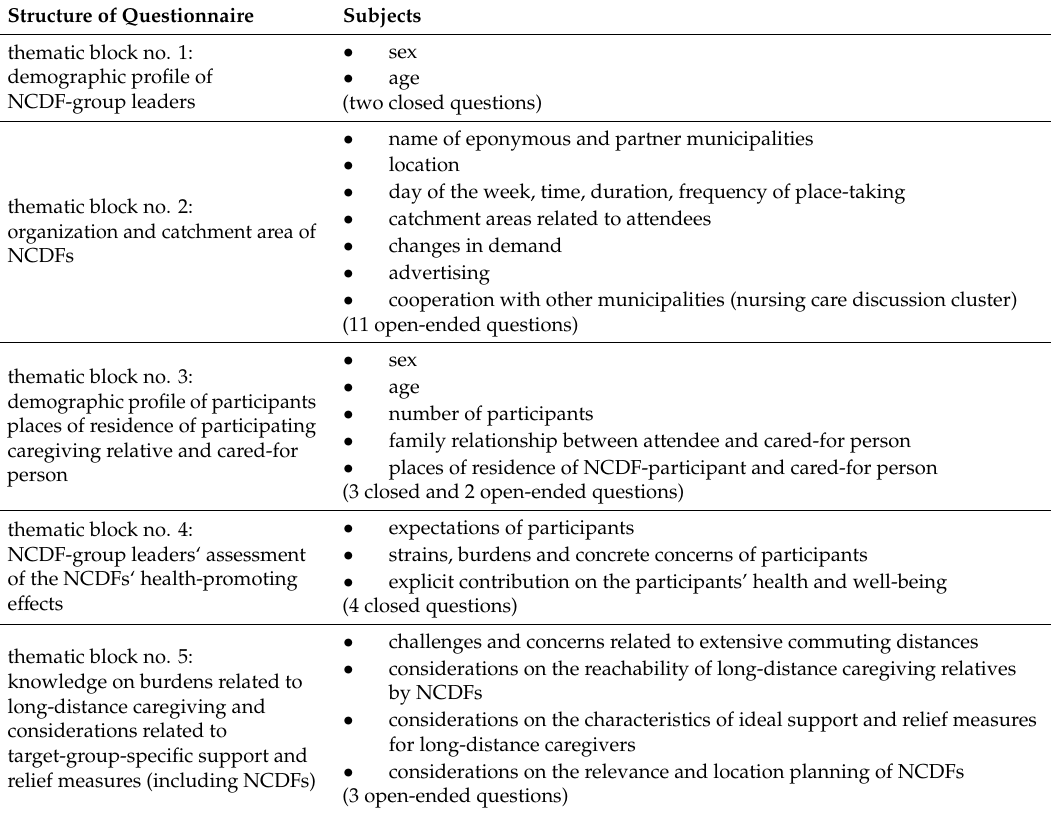
Table 1. Structure and content of the questionnaire for the written expert